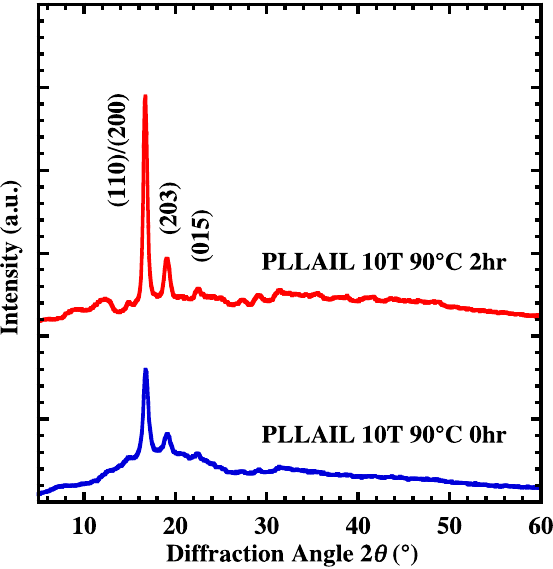
Figure 6. XRD patterns of PLLAIL10T and PLLAIL10T2 films.